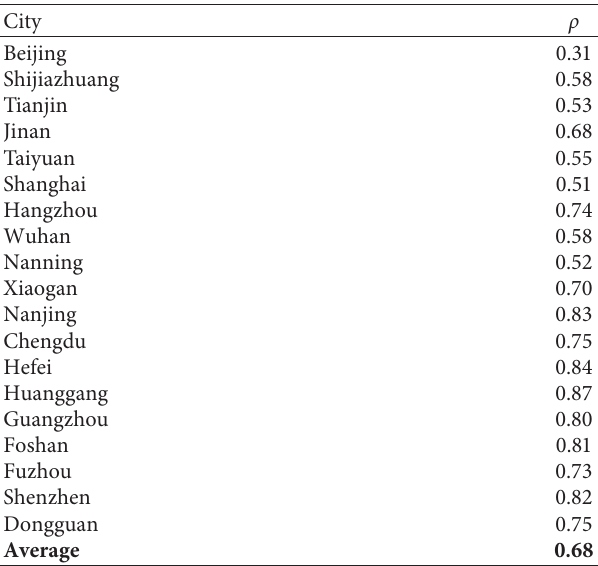
Table 2: Correlation coefficient between the physiological anomaly rate and the officially reported number of newly confirmed COVID-19